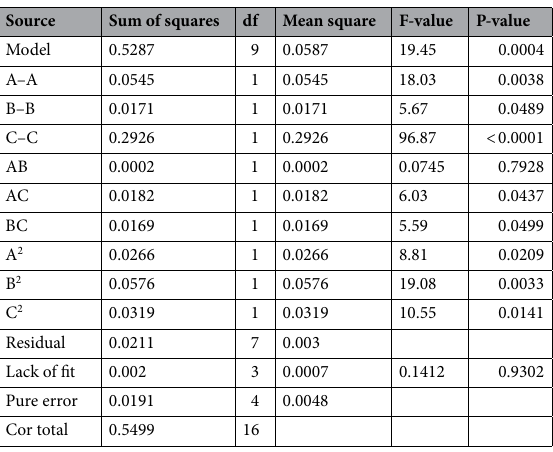
Table 2. The regression model for predicting the best conditions for M. luteus inhibition with the analysis of variance (MANOVA).